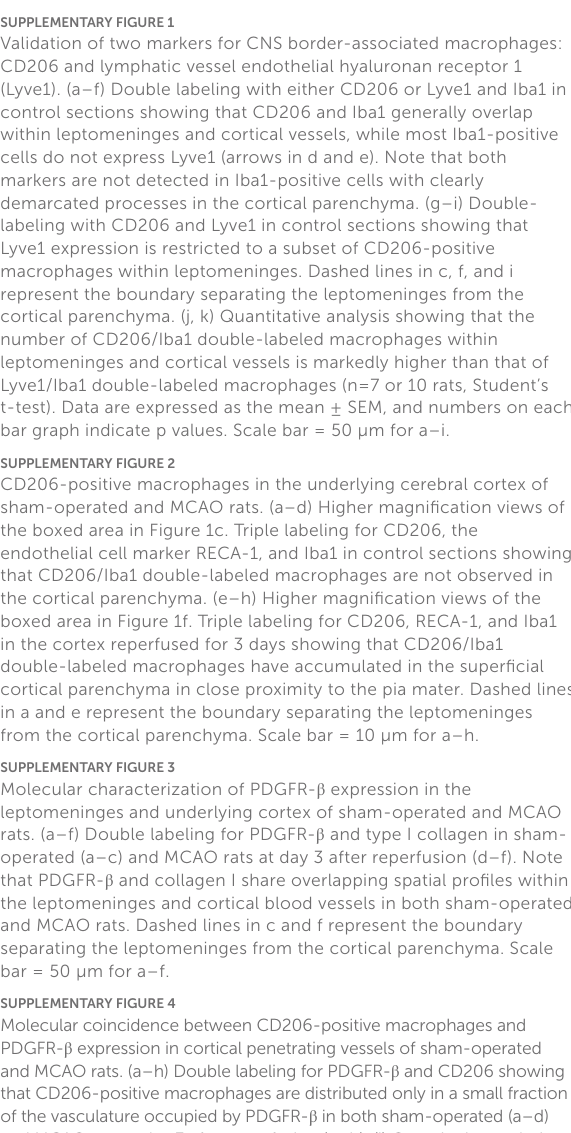
SUPPLEMENTARY FIGURE 1 Validation of two markers for CNS border-associated macrophages: CD206 and lymphatic vessel endothelial hyaluronan receptor 1 (Lyve1). (a–f) Double labeling with either CD206 or Lyve1 and Iba1 in control sections showing that CD206 and Iba1 generally overlap within leptomeninges and cortical vessels, while most Iba1-positive cells do not express Lyve1 (arrows in d and e). Note that both markers are not detected in Iba1-positive cells with clearly demarcated processes in the cortical parenchyma. (g–i) Double- labeling with CD206 and Lyve1 in control sections showing that Lyve1 expression is restricted to a subset of CD206-positive macrophages within leptomeninges. Dashed lines in c, f, and i represent the boundary separating the leptomeninges from the cortical parenchyma. (j, k) Quantitative analysis showing that the number of CD206/Iba1 double-labeled macrophages within leptomeninges and cortical vessels is markedly higher than that of Lyve1/Iba1 double-labeled macrophages (n=7 or 10 rats, Student’s t-test). Data are expressed as the mean ± SEM, and numbers on each bar graph indicate p values. Scale bar = 50 μm for a–i. SUPPLEMENTARY FIGURE 2 CD206-positive macrophages in the underlying cerebral cortex of sham-operated and MCAO rats. (a–d) Higher magnification views of the boxed area in Figure 1c. Triple labeling for CD206, the endothelial cell marker RECA-1, and Iba1 in control sections showing that CD206/Iba1 double-labeled macrophages are not observed in the cortical parenchyma. (e–h) Higher magnification views of the boxed area in Figure 1f. Triple labeling for CD206, RECA-1, and Iba1 in the cortex reperfused for 3 days showing that CD206/Iba1 double-labeled macrophages have accumulated in the superficial cortical parenchyma in close proximity to the pia mater. Dashed lines in a and e represent the boundary separating the leptomeninges from the cortical parenchyma. Scale bar = 10 μm for a–h. SUPPLEMENTARY FIGURE 3 Molecular characterization of PDGFR- β expression in the leptomeninges and underlying cortex of sham-operated and MCAO rats. (a–f) Double labeling for PDGFR- β and type I collagen in sham- operated (a–c) and MCAO rats at day 3 after reperfusion (d–f). Note that PDGFR- β and collagen I share overlapping spatial profiles within the leptomeninges and cortical blood vessels in both sham-operated and MCAO rats. Dashed lines in c and f represent the boundary separating the leptomeninges from the cortical parenchyma. Scale bar = 50 μm for a–f. SUPPLEMENTARY FIGURE 4 Molecular coincidence between CD206-positive macrophages and PDGFR- β expression in cortical penetrating vessels of sham-operated and MCAO rats. (a–h) Double labeling for PDGFR- β and CD206 showing that CD206-positive macrophages are distributed only in a small fraction of the vasculature occupied by PDGFR- β in both sham-operated (a–d) and MCAO rats at day 3 after reperfusion (e–h). (i) Quantitative analysis showing that the vascular length occupied by CD206 is significantly higher than that of PDGFR- β -positive vessels within the cortical parenchyma in both sham-operated and MCAO rats (n = 6–9 rats; one- way ANOVA with Tukey’s multiple comparison test). Data are expressed as the mean ± SEM, and numbers on each bar graph indicate p values. Scale bar = 50 μm for